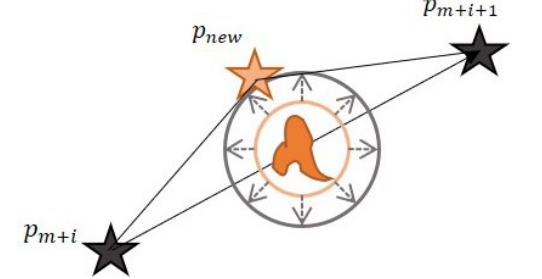
Figure 5. Obstacle avoidance strategy: extend the outer circle of obstacles to CIR 2 s and find a free point set on the circle. If there is no solution found, CIR 2 s must be extended